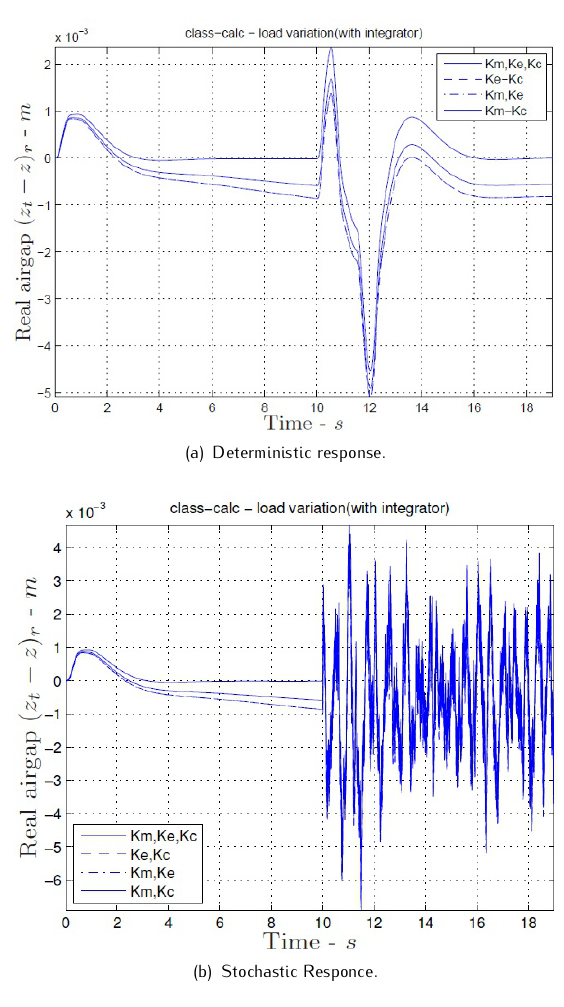
Figure 14. Closed-loop response of the suspension to disturbance inputs under load variation with SZI.